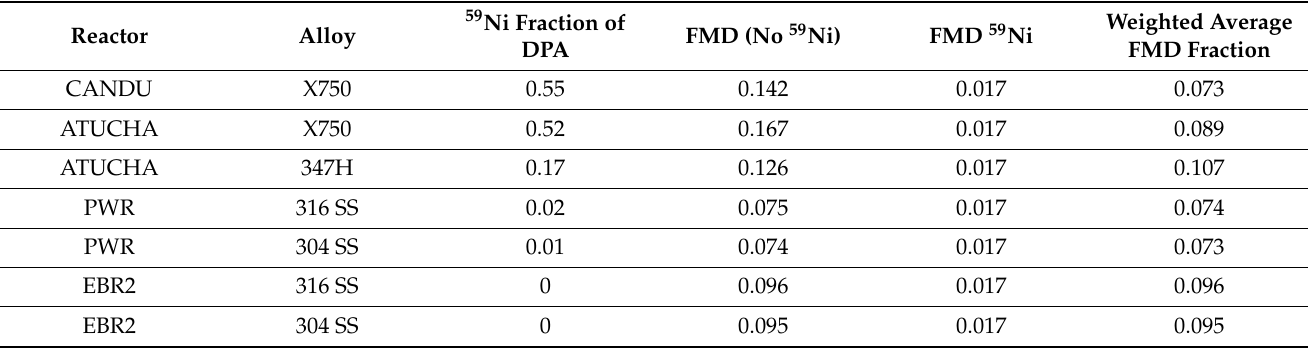
Table 2. Combined FMD fractions for different alloys in various reactors using Equation (2) and reactor specific PKA spectra considering the relative contributions from the displacements arising from 59 Ni effects at a dose of 100